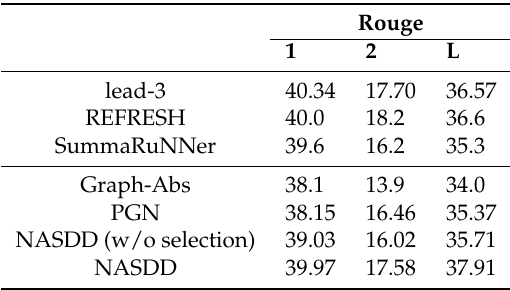
Table 2. ROUGE F1 scores on the test set. All of these ROUGE scores have a 95% confidence interval of at most ± 0.25 as reported by the official ROUGE script. PGN, Pointer Generator Network; NASDD, Neural Abstractive Summarization with Diverse Decoding.